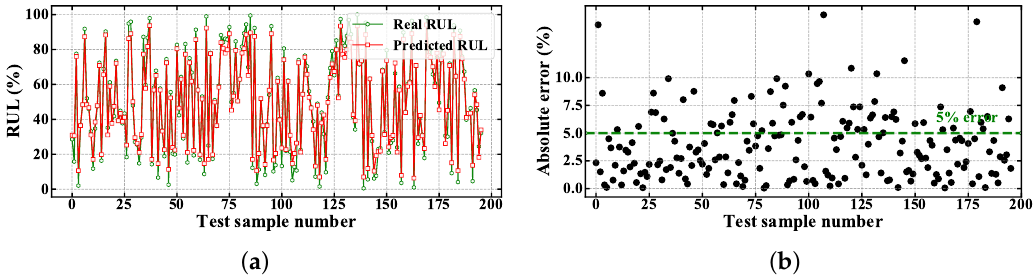
Figure 12. Results of experimental case 3. RUL prediction results and absolute errors when Battery #33 is the test set and Batteries #5, #6 and #7 are the training set: ( a ) The RUL prediction results. ( b ) The absolute